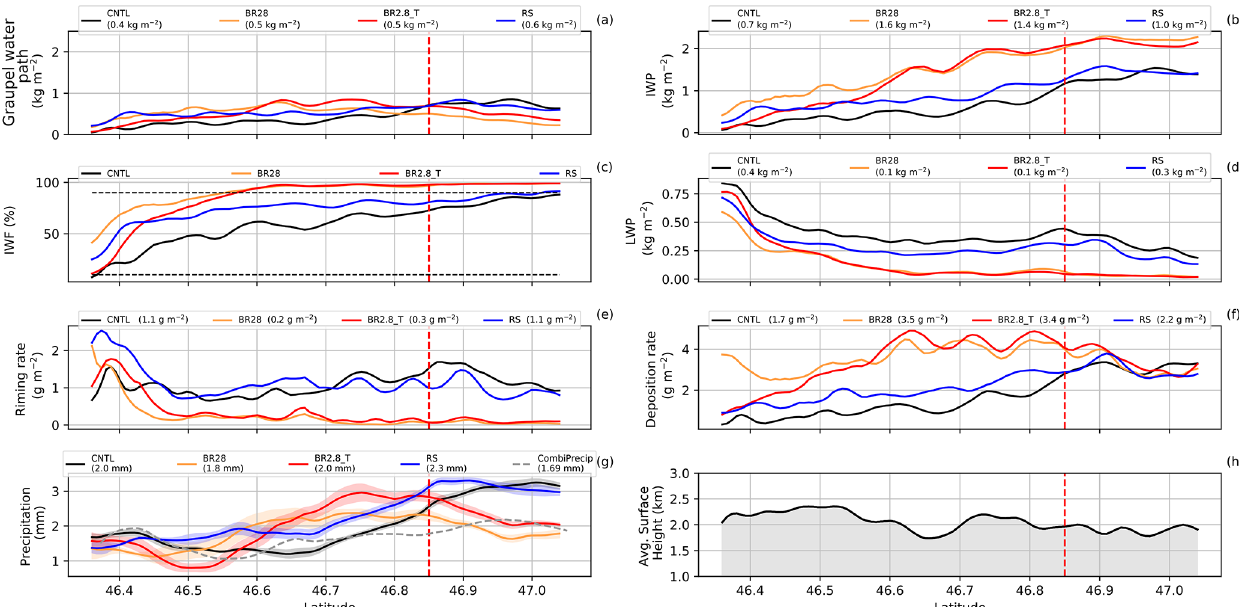
Figure 10. (a) Graupel water path, (b) IWP (ice water path), (c) IWF (ice water fraction) (IWP/(IWP + LWP)) × 100, (d) LWP, (e) riming rate and (f) deposition rate over the cross section. These quantities calculated in panels (a) – (f) were only over cloudy regions, where the cloud area fraction is larger than 0. In parentheses are the average over the latitude. Panel (g) shows the precipitation mean (solid line), ensemble spread (shaded area) and CombiPrecip (dashed line), and panel (h) shows the averaged topography over the cross section. The red vertical dashed line indicates the latitude of